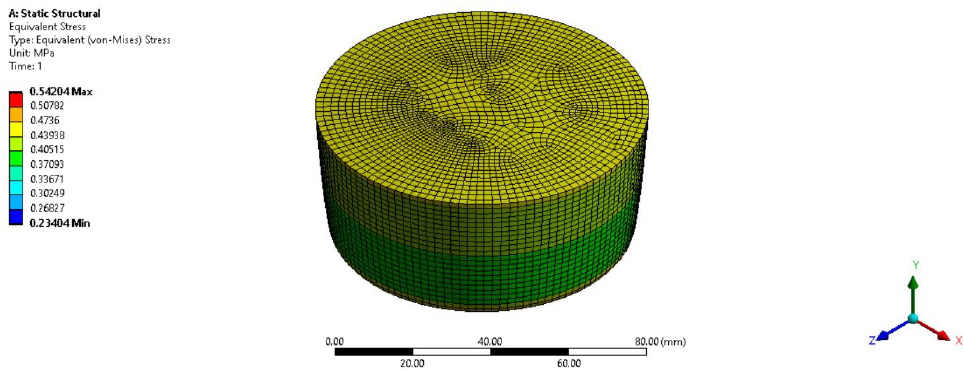
Figure 12. Displacements of the tested specimen (deformed state).